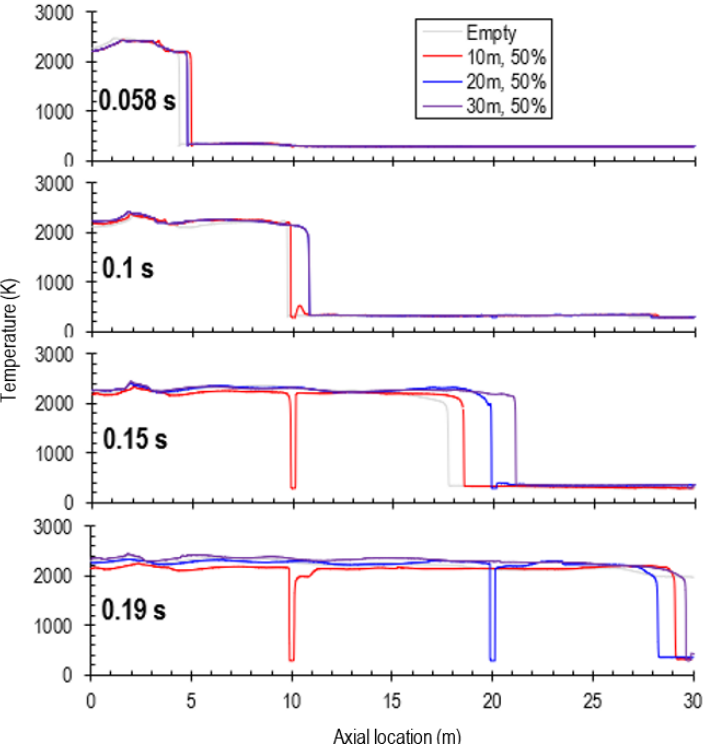
Figure 8. Evolution of temperature profiles along the tube centreline for different scenarios where a single obstruction is installed at different locations (at 10 m, 20 m and 30 m) with 50% inflation. The temperature profiles in the empty tube are also included for reference.